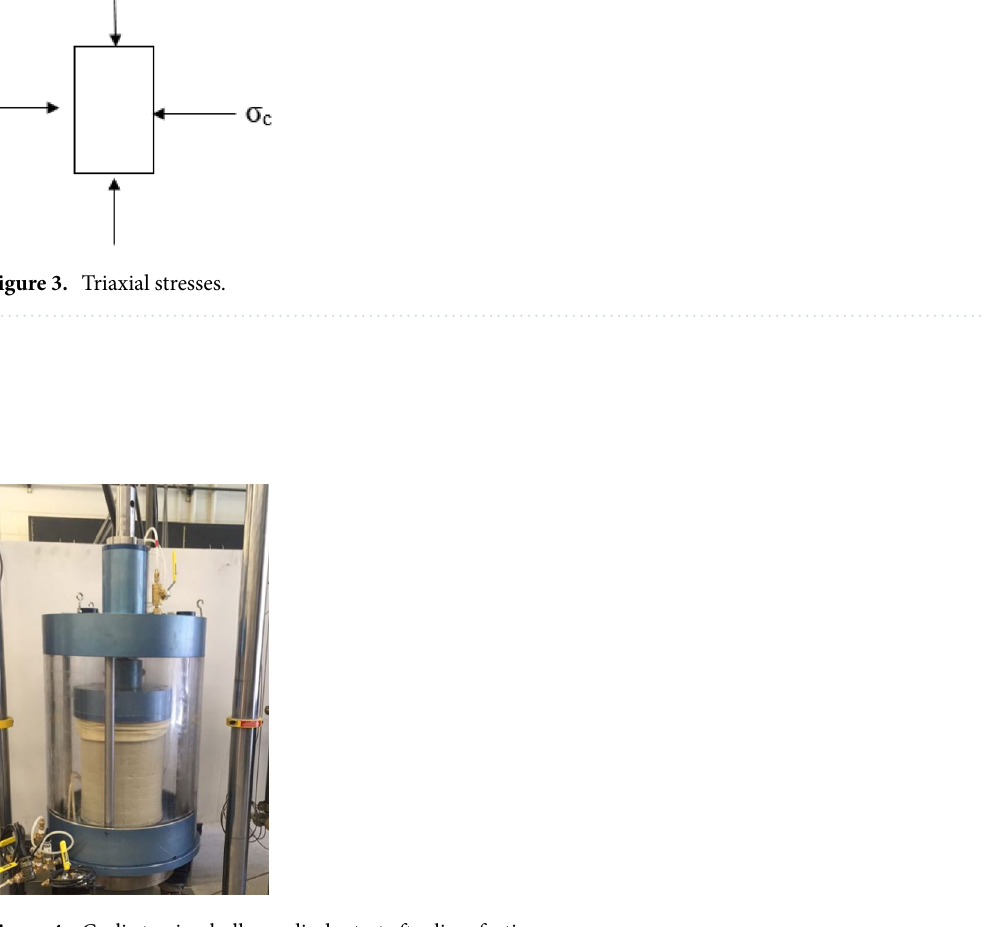
Figure 4. Cyclic torsion hollow cylinder test after